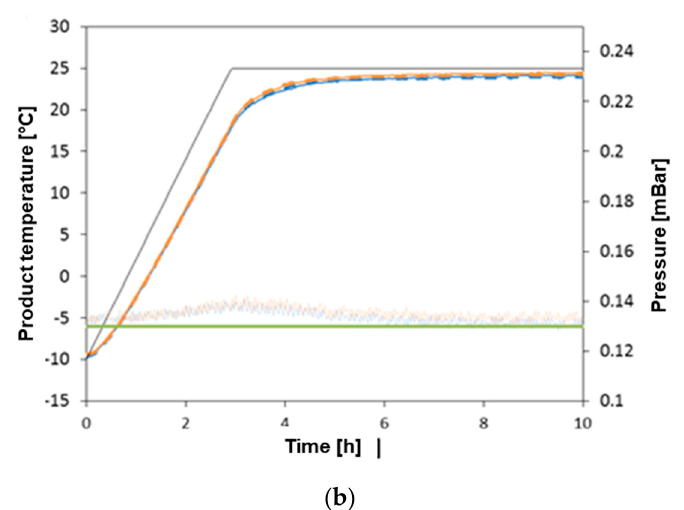
Pressure: combined for 5.4 mL and 10.6 mL configuration ― MKS //// Pirani ctrl. //// Pirani unctrl.